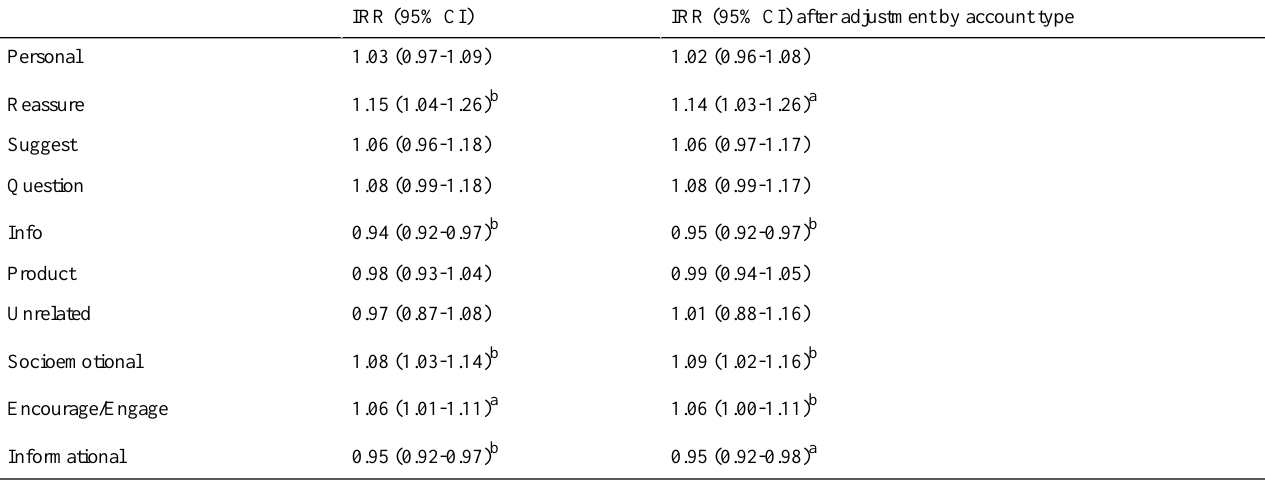
Table 3. Association of number of followers and frequency of